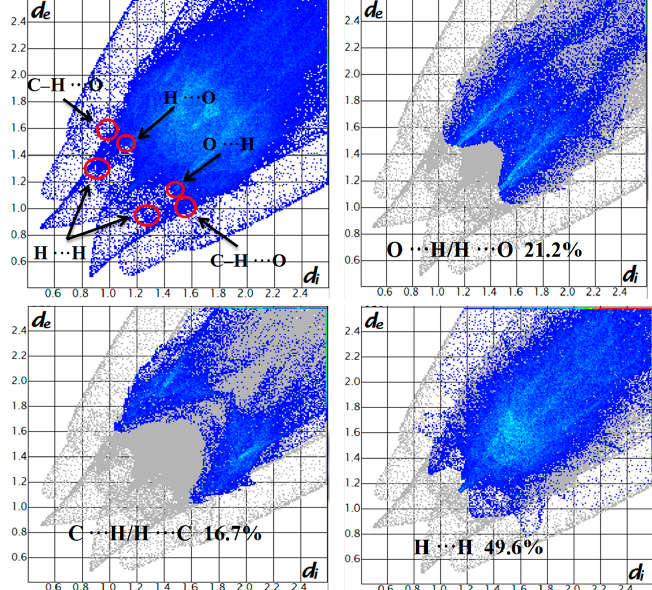
Figure 7. Fingerprint plot of the Zn II coordination compound: full and resolved into full and resolved